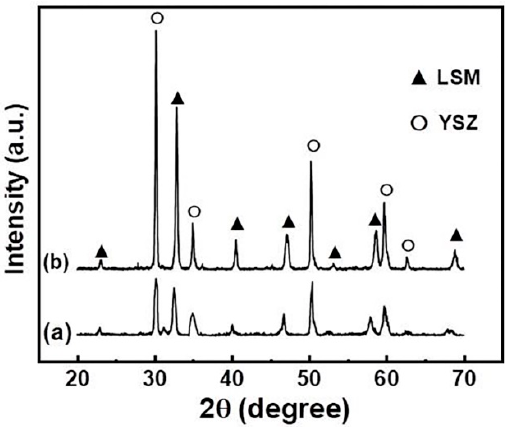
Figure 2. XRD pattern of YSZ/LSM deposits: ( a ) as-sprayed and ( b ) after annealing at 1050 °C for 2 h in air.